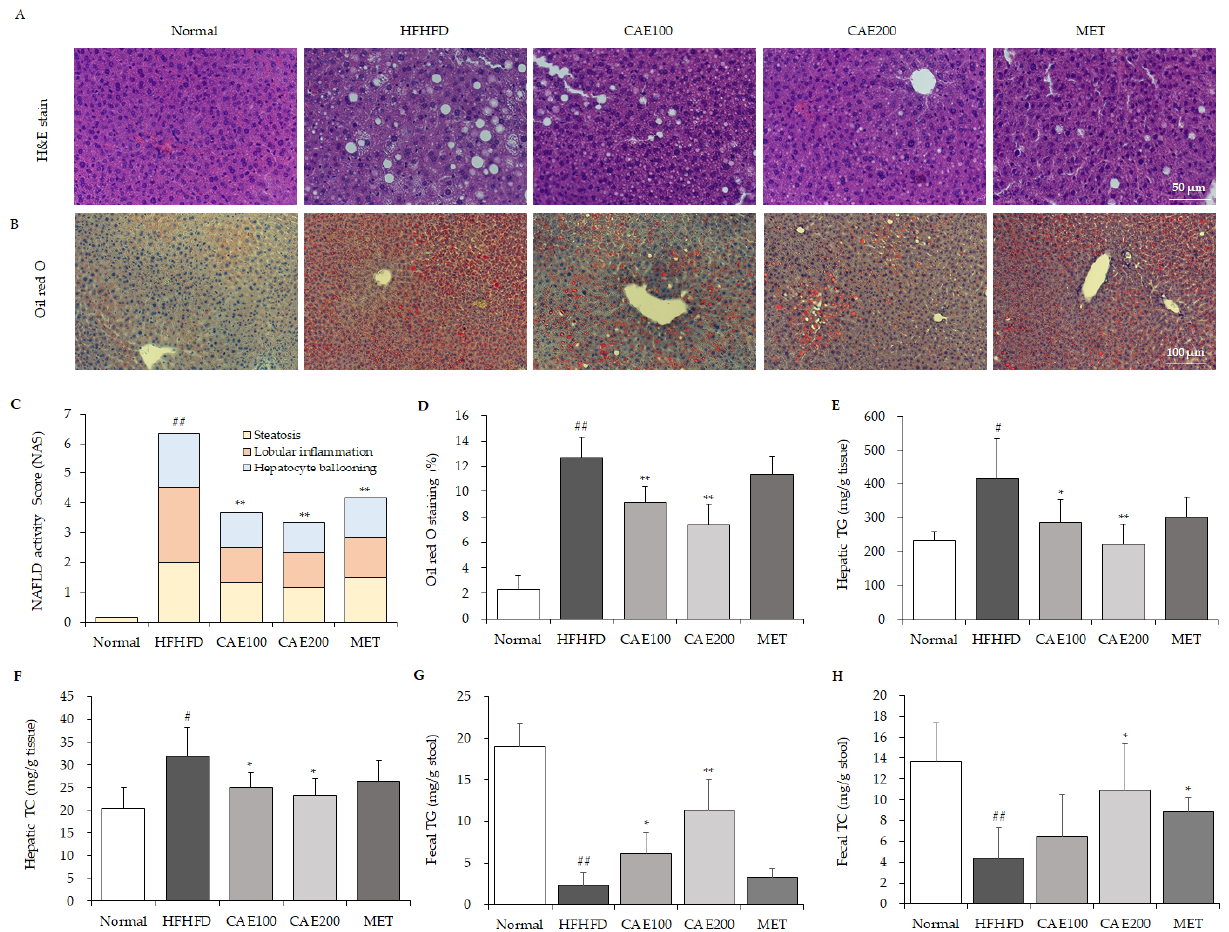
Figure 3. CAE inhibits lipid accumulation in liver tissue. The hepatic tissues were stained with H&E ( A ) and oil red O ( B ) separately (n = 6). The NAFLD activity score ( C ), including steatosis, lobular inflammation, and hepatocyte ballooning scores, was applied to compare the NAFLD grade. ImageJ software was used to quantify lipid accumulation from findings of oil red O staining ( D ). The hepatic and fecal triglycerides ( E , G ) and total cholesterol ( F , H ) values were determined using commercial enzymatic assay kits (Asan Pharmaceutical Co., Seoul, Korea) (n = 6). # p < 0.05 and ## p < 0.01, as compared to normal group; * p < 0.05 and ** p < 0.01, as compared to the HFHFD group. The CBC results showed that an HFHFD significantly increased the platelet count and markedly lowered the WBC count ( p < 0.05, Table 2) without showing changes in RBC and hemoglobin levels. In detail, an HFHFD markedly decreased the count of lympho- cytes ( p < 0.05, Table 2), but not monocytes and granulocytes. CAE noticeably reduced the platelet count and the platelets to lymphocytes ratio (PLR) and, meanwhile, distinctly in- hibited the lessening of leucocyte numbers, especially lymphocytes, but not monocytes and granulocytes ( p < 0.05 or p < 0.01, Table 2). Moreover, metformin also produced a pattern that was similar to CAE.